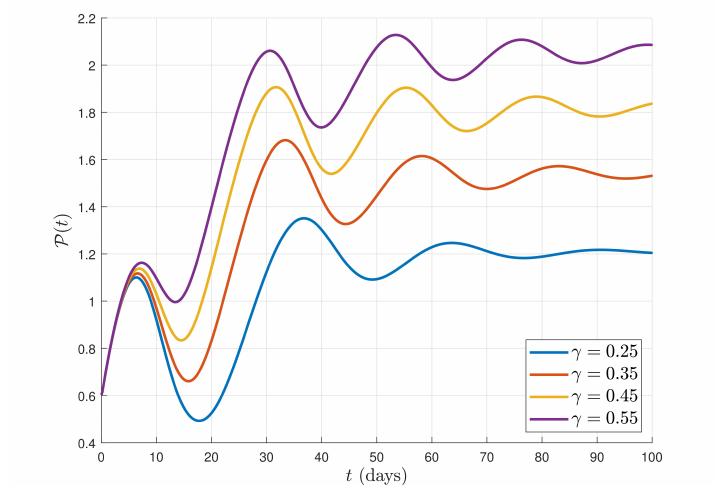
Figure 12. Effects of contact rates on state functions: P ( t ) versus γ .